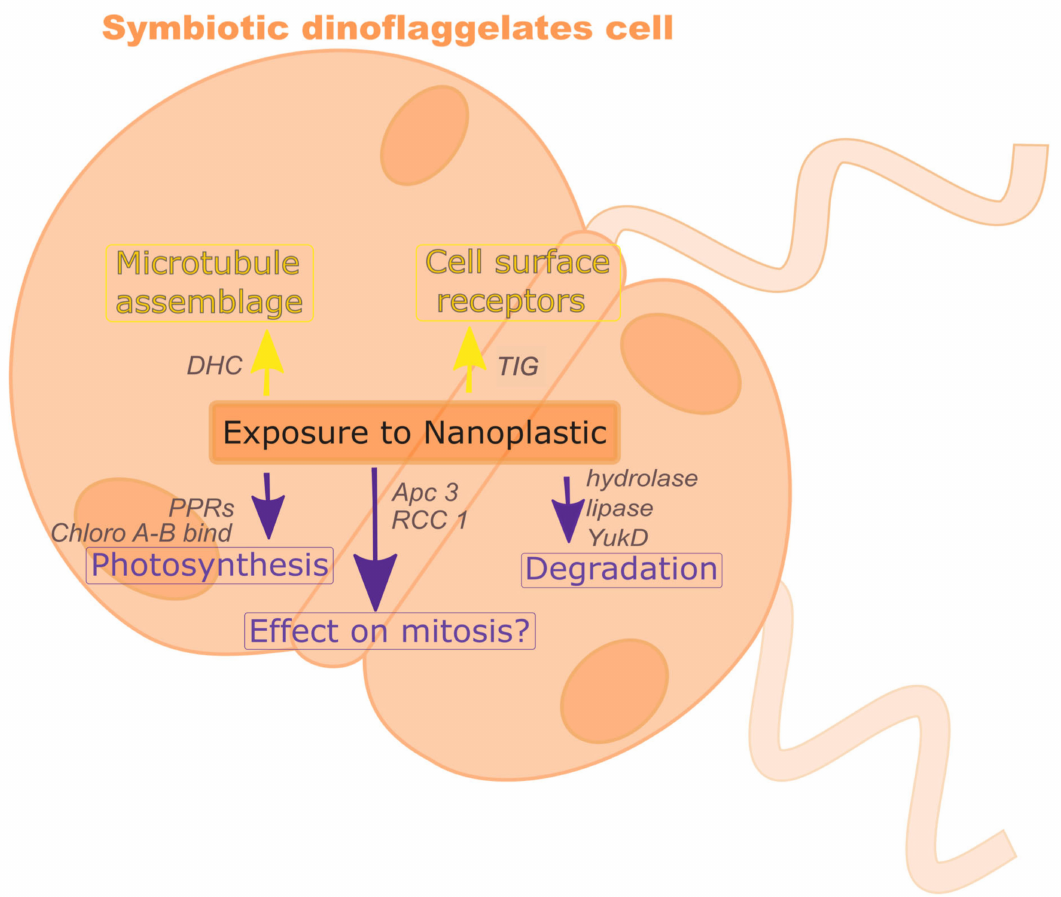
Figure 5. Exposure to nanoPS 42 changes gene expression levels in symbiotic dinoflagellates. Yellow and purple arrows show up-regulation and down-regulation of gene expression, respectively.